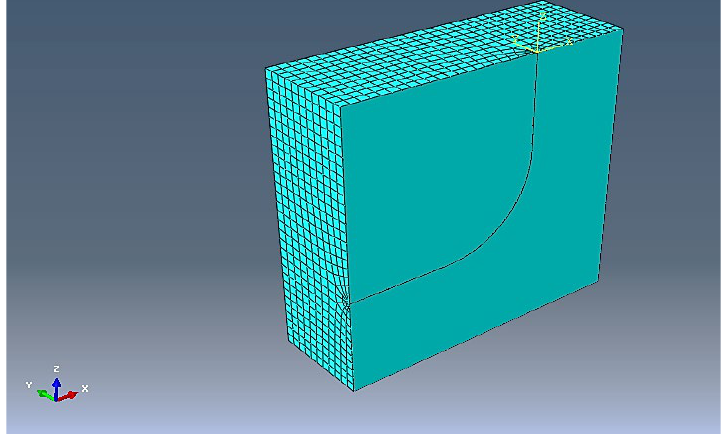
Figure 16. A schematic view of the 3D finite-element model from wellbore-D in the Azar oilfield. At last, the wellbore finds a horizontal state. With the porosity and fluid in rocks, the modeling analysis moved further to the depths and caused changes in the geo-mechanical behavior of the Sarvak Formation. On the other hand, an elastic model with no considera- tion of porosity and pore fluid creates a hypothesis with an immense error in understanding the process. This is because pore spaces [33], pore fluids, and their connection within the wellbore play a crucial role in addressing the issues of the drilling operation. In this re- gard, lack of porosity causes an increase in shear and tensile strengths, resulting in an invalid